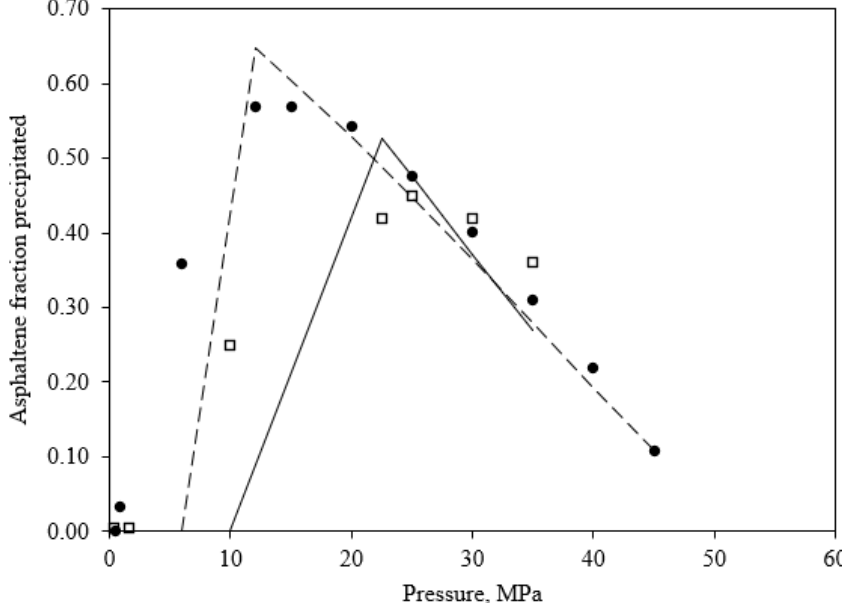
Figure 3. Pressure and temperature effects on precipitated asphaltene fraction calculated by Li and Firoozabadi. Experimental data ( ● ) by Szewczyk et al., at 30 °C for oil X2, ( ━ ━ ) calculated. Experimental data ( □ ) by Szewczyk et al., at 30 °C for oil X3 ( ━ ) calculated.